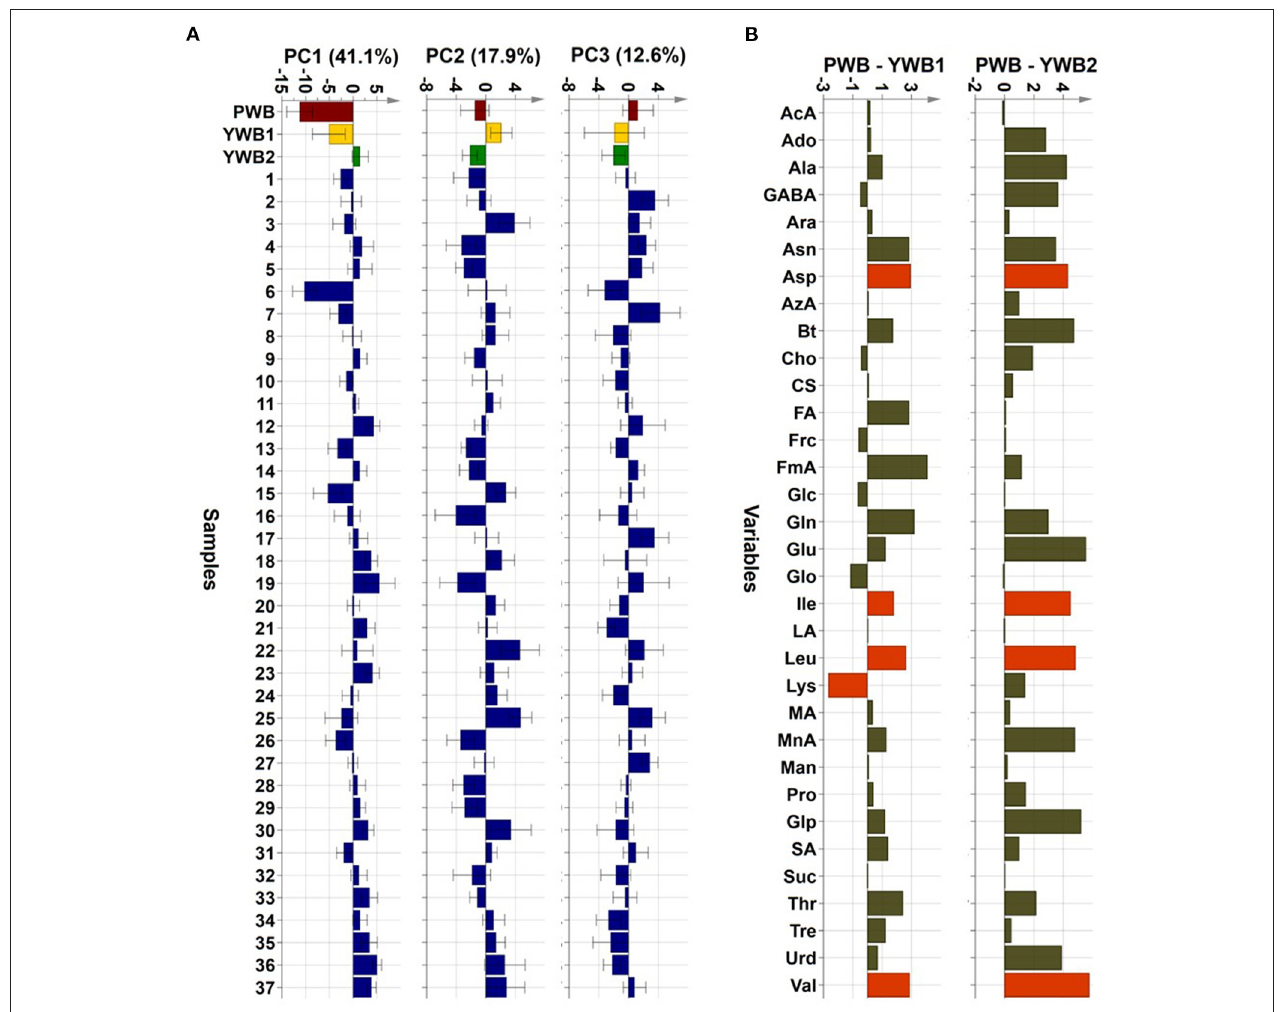
FIGURE 3 | (A) PCA scores on the first three components (PC1, PC2, and PC3, respectively, left to right). (B) Contribution scores plots from YWB1 to PWB (left) and from YWB2 to PWB (right) (p1 loading was used as a single weight; variables outside three-fold standard deviation ranges are highlighted in